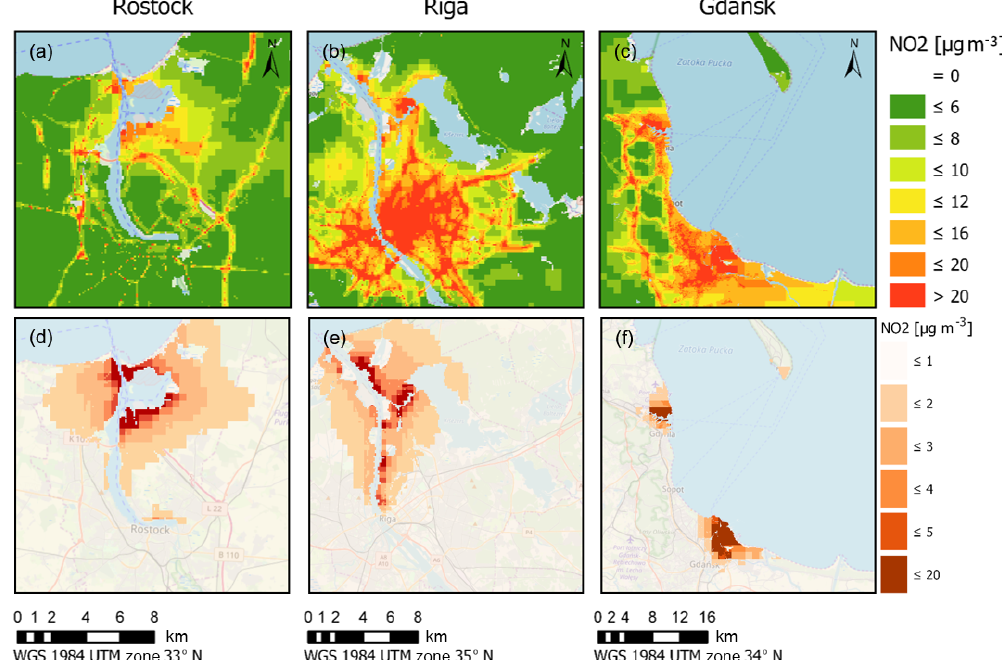
Figure 7. NO 2 annual mean concentrations in Rostock (a) , Riga (b) and Gda´nsk–Gdynia (c) , and contribution of local shipping to annual mean NO 2 concentration in Rostock (d) , Riga (e) and Gda´nsk–Gdynia (f) . Maps are created using © 2018 ESRI Inc. ArcGIS Pro 2.3.2 with